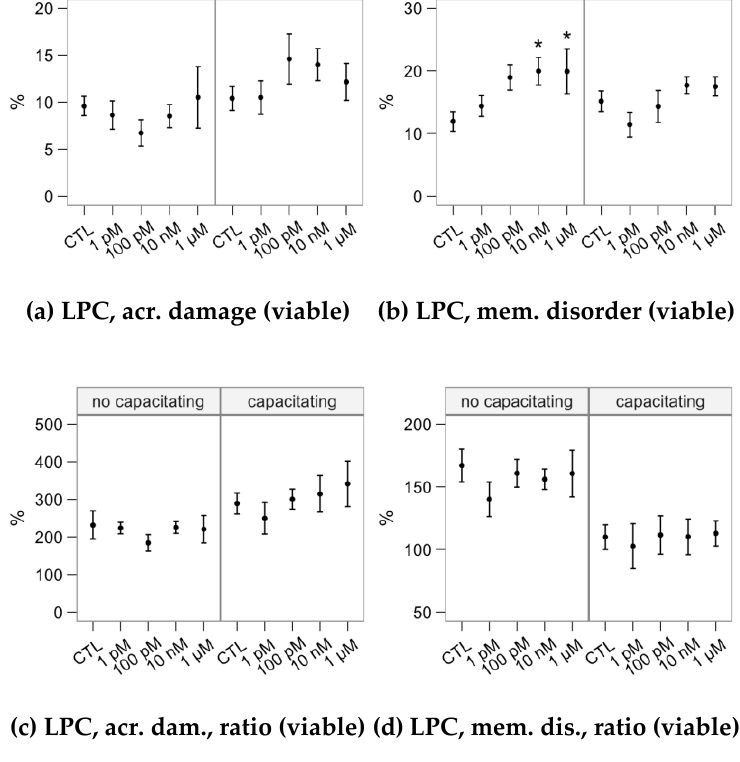
Figure 8. Effects of incubating bull spermatozoa with different melatonin concentrations on the response to the lysophosphatidylcholine challenge (Control, no melatonin, as reference). Plots show mean ± SEM for each concentration in the two in the absence (no capacitating) or presence (capacitating) of heparin (variable names expanded in Figure 3). The melatonin treatment did not show a significant effect on these variables.